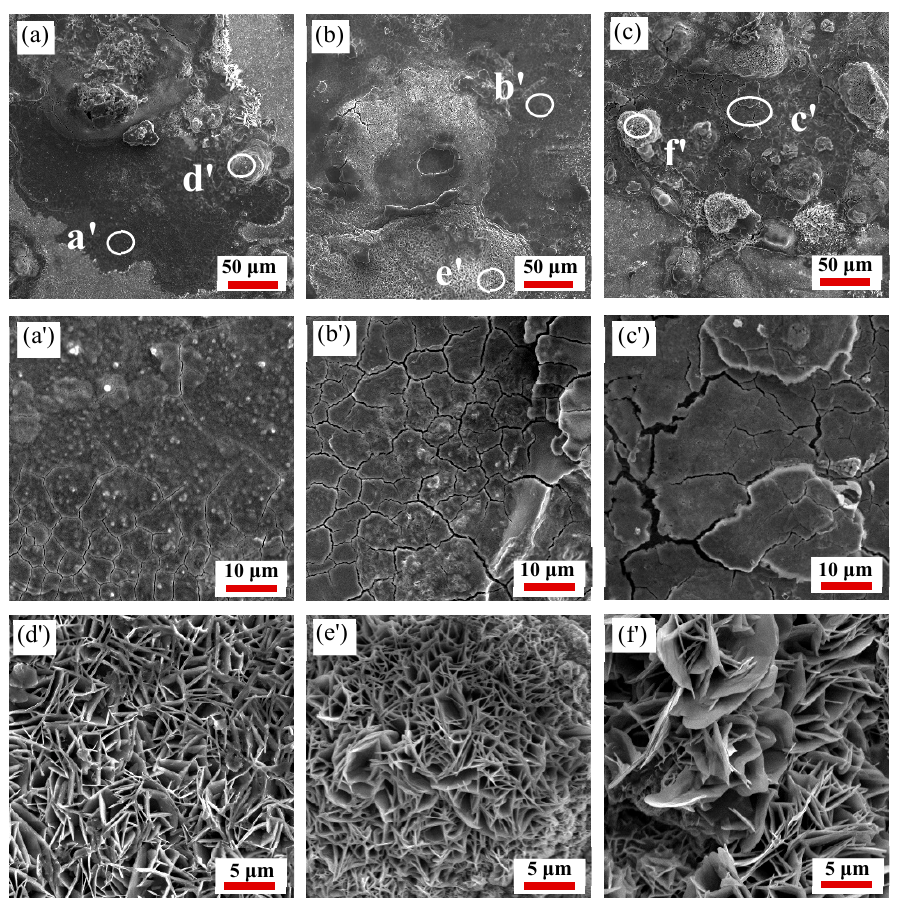
Figure 13. SEM corrosion morphology of the 35CrMoV steel: ( a ), ( a ' ), ( d ' ) 10 s − 1 , 850 °C; ( b ), ( b ' ), ( e ' ) 10 s − 1 , 950 °C; and ( c ), ( c ' ), ( f ' ) 10 s − 1 , 1050 °C.